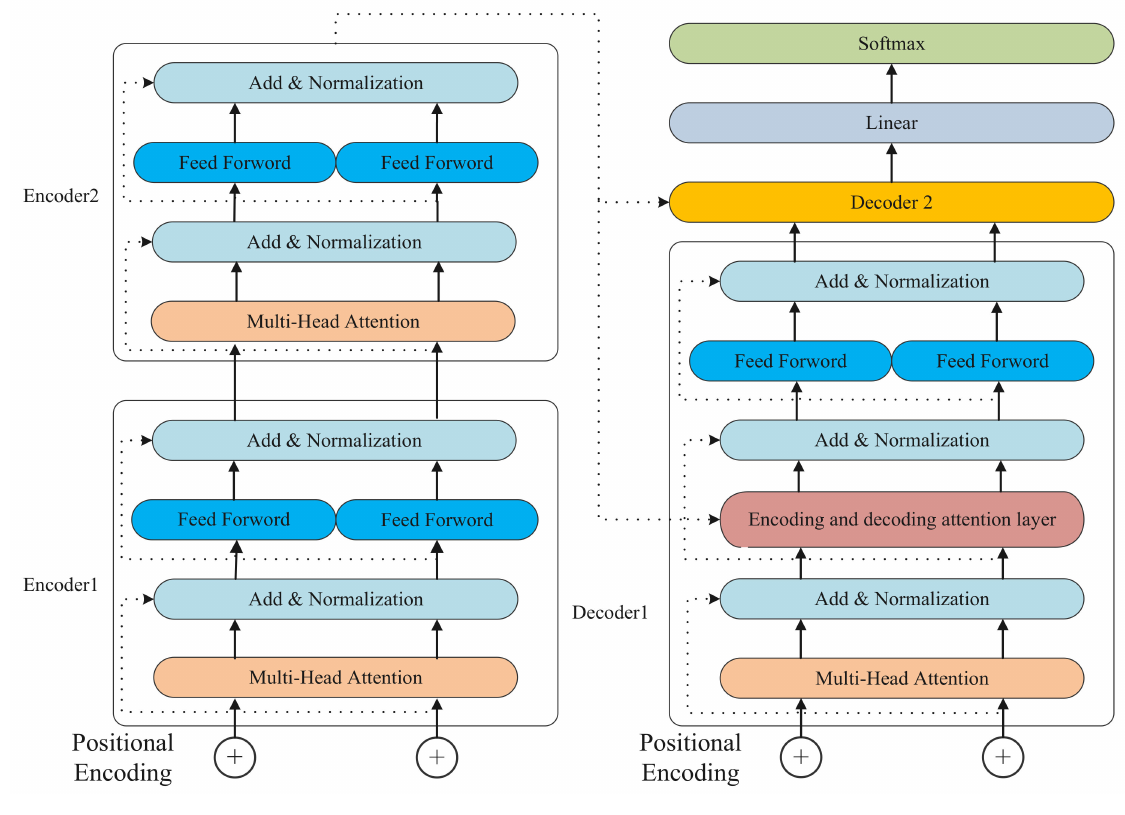
Figure 2. Transformer model structure.